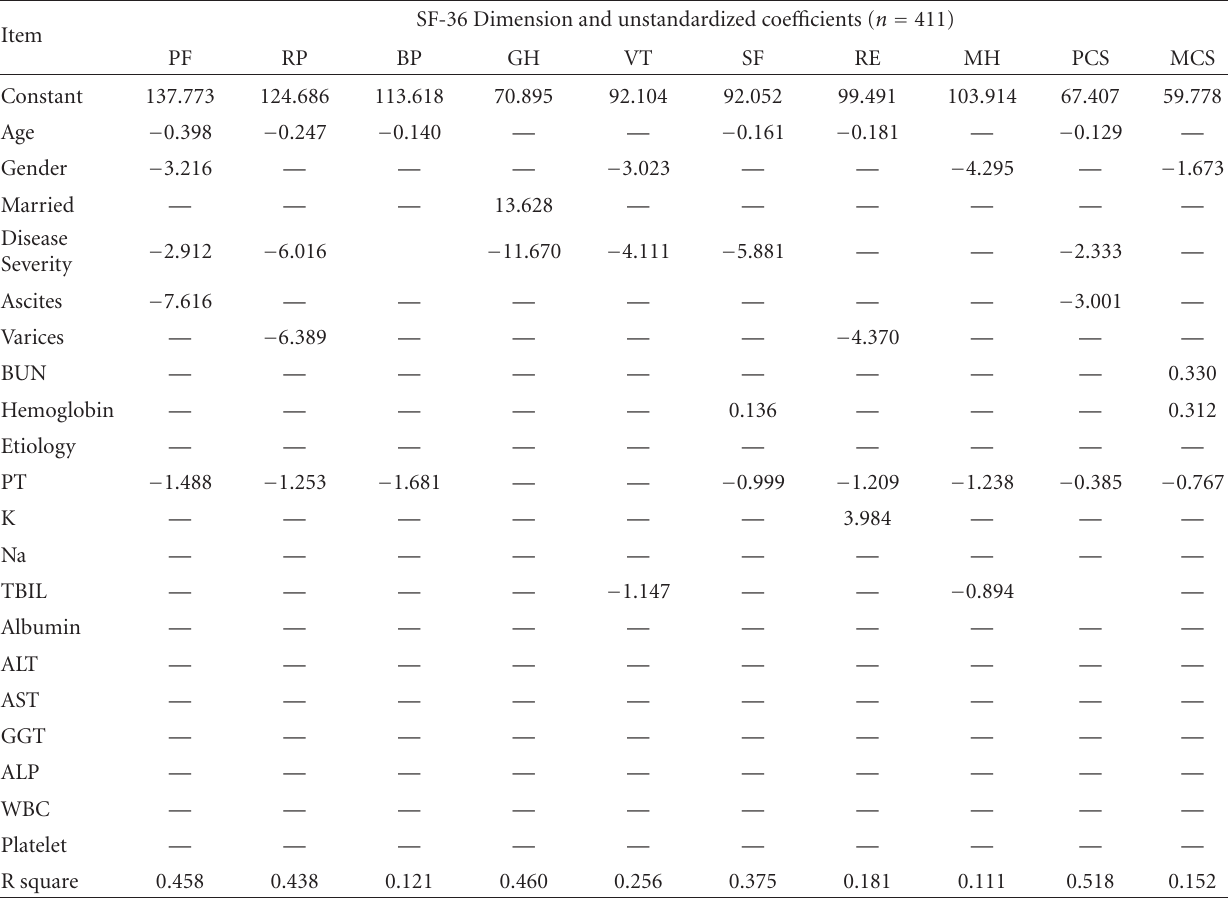
Table 4: Results of stepwise linear regression